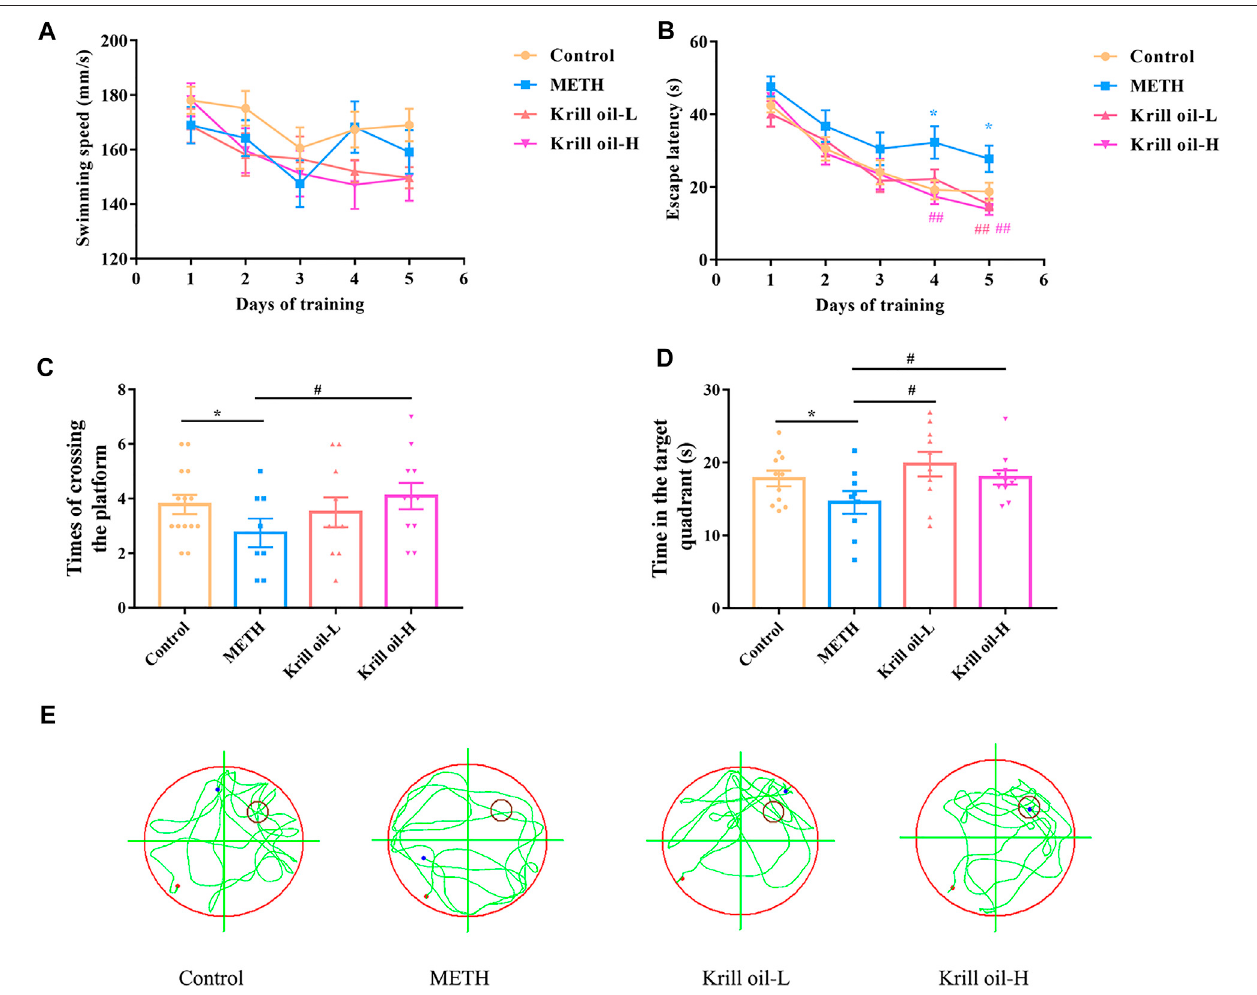
FIGURE 2 | Krill oil – ameliorated impairment of spatial learning and memory induced by METH in the MWM task. (A) Swimming speed of each group during the training session. The Morris water maze test was conducted to evaluate spatial learning and memory function. (B) Acquisition of spatial memory in mice. The escape latency during the training phase was shown. (C) Retention of spatial memory in mice. Times of crossing the platform of mice were shown. (D) Retention of spatial memoryinmice.Thetime inthetargetquadrant ofmice wasshown. (E) RepresentativeswimmingtrajectoriesofMorris watermaze testing. n (cid:1) 10foreach group, and data were presented by means ± SEM, * p < 0.05, ** p < 0.01 compared to the control group, and # p < 0.05, ## p < 0.01 compared to the METH group.